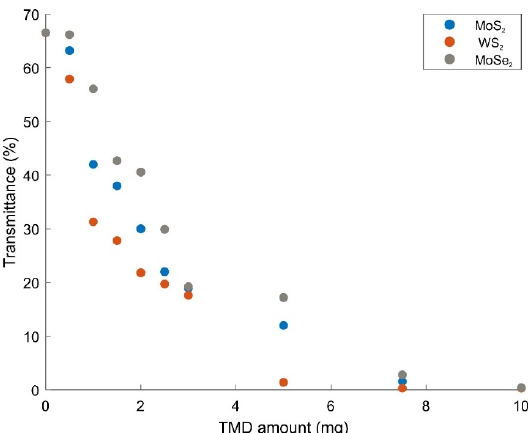
the band gap energy.